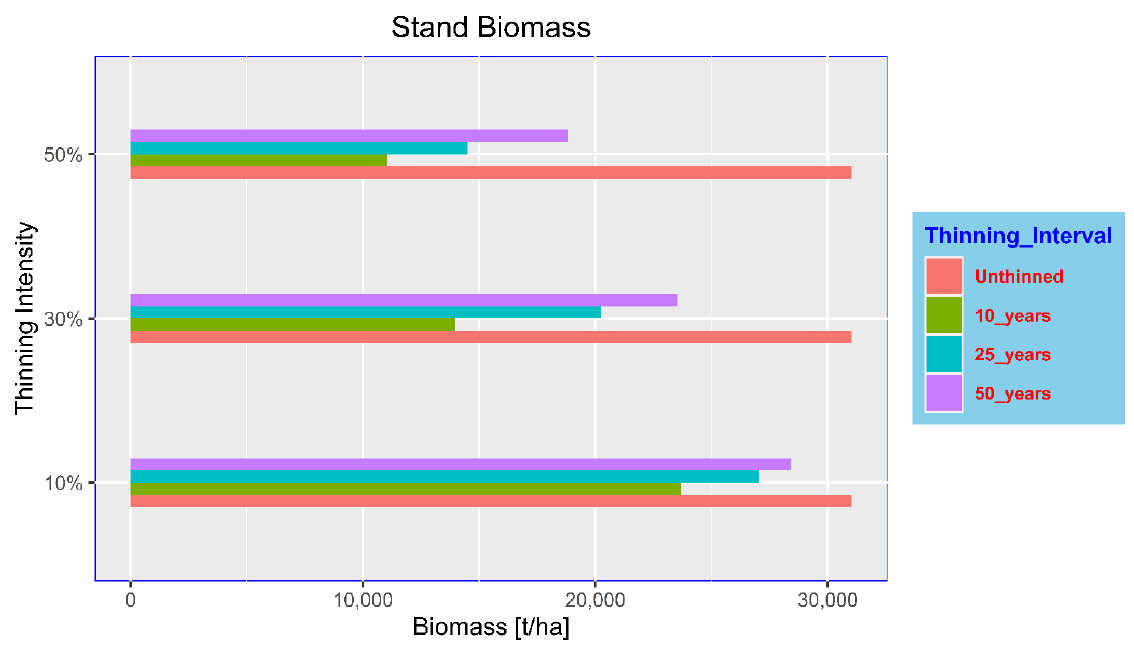
Figure 7. Stand biomass over the management period. For calculation of accumulated biomass, thinned stem, thinned foliage, and thinned root biomass were accumulated and added to the stand biomass predicted by the model. Heavy thinning at longer interval accumulated the highest biomass (1.5% more than in un-thinned stand). Nevertheless, accumulated biomass does not change much in response to the used thinning regimes. (Figure 8).